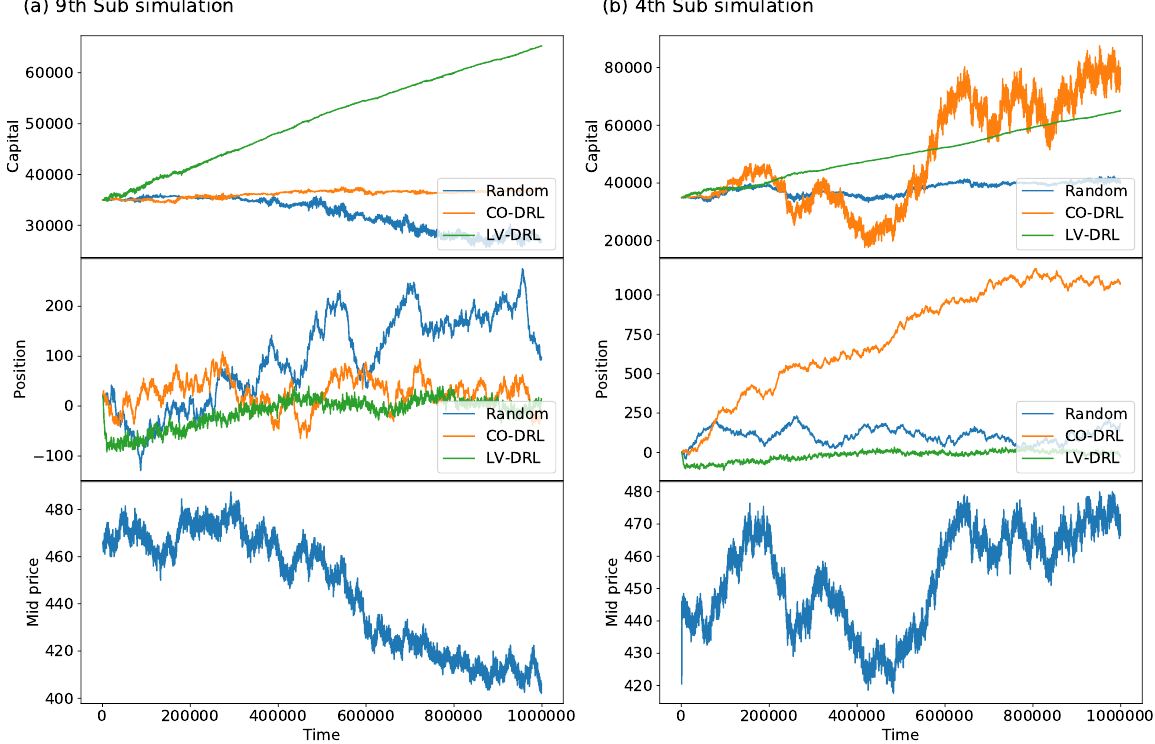
Figure 5. Example capital changes of sub simulations in validation. Both left and right columns show changes of capital, inventory, and mid price in one typical sub